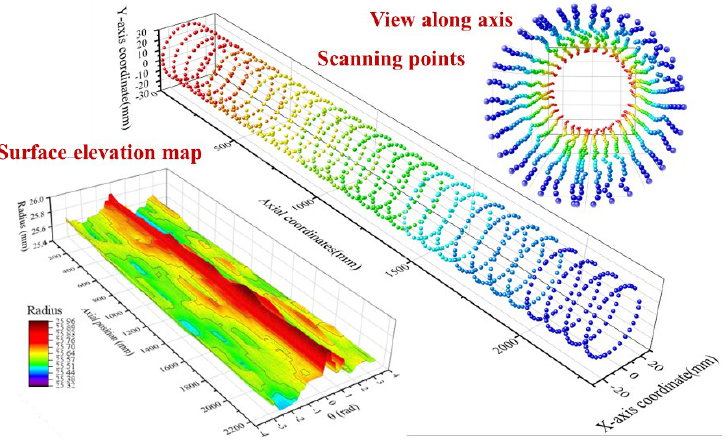
Figure 3. Schematic scanning points.